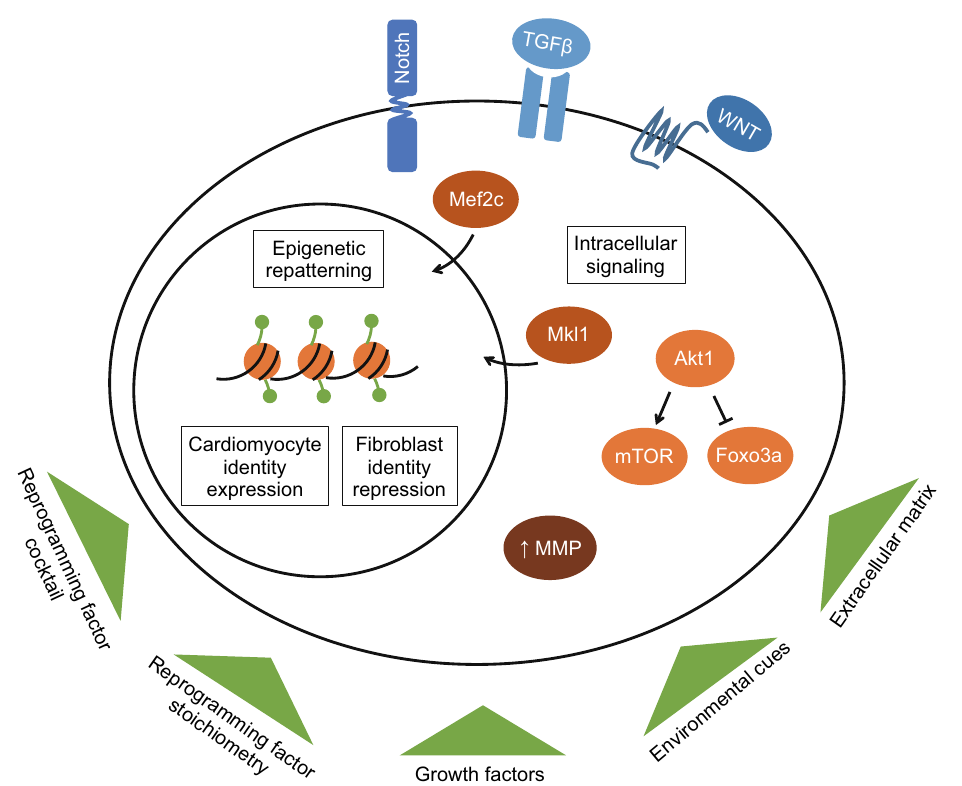
Figure 1. Exogenous factors including reprogramming factor cocktails and stoichiometry and environmental stimuli alter intracellular signaling pathways and epigenetic repatterning to suppress fi broblast gene expression and promote cardiomyocyte gene expression to enhance direct cardiac